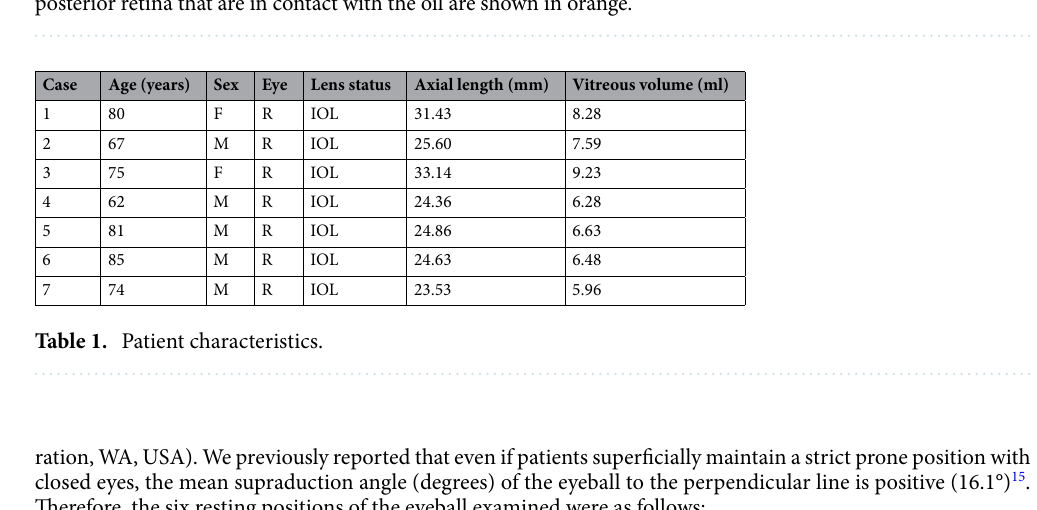
Figure 2. Measurement of the oil cover rate of the inferior retina in the sitting position with the vitreous cavity filled with 95% oil in case 1. ( A ) The three-dimensional vitreous cavity of case 1 filled with a combination of